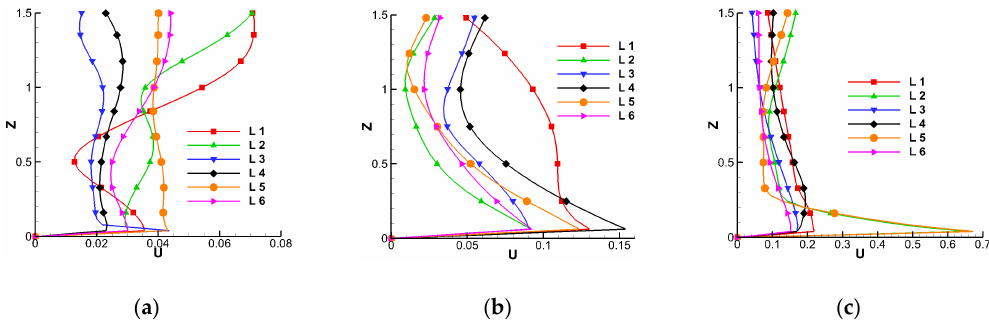
Figure 12. Velocity distributions along different lines in the center of subzones in Model II: ( a ) Down- supply up-return; ( b ) floor-supply up-return; ( c ) top-supply down-return.